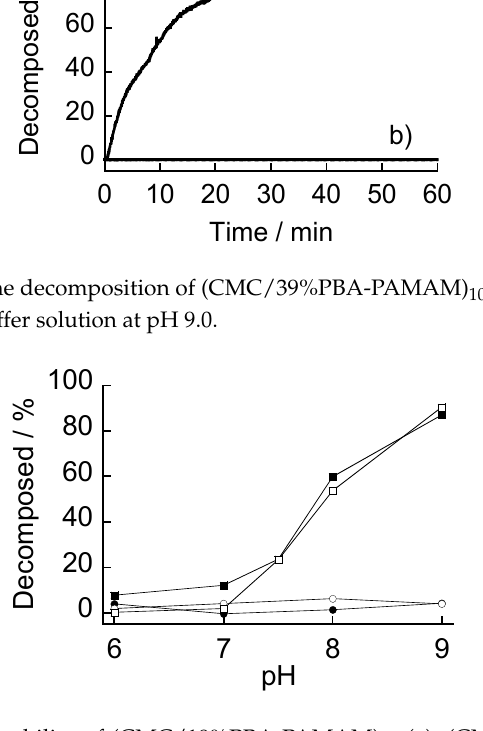
Figure 6. pH-dependent stability of (CMC/19%PBA-PAMAM) 10 ( □ ), (CMC/39%PBA-PAMAM) 10 ( ■ ), (AGA/19%PBA-PAMAM) 10 ( ○ ), and (AGA/39%PBA-PAMAM) 10 films ( ● ). The percentages of decomposition after immersing the films in the buffer solutions for two hours are plotted.